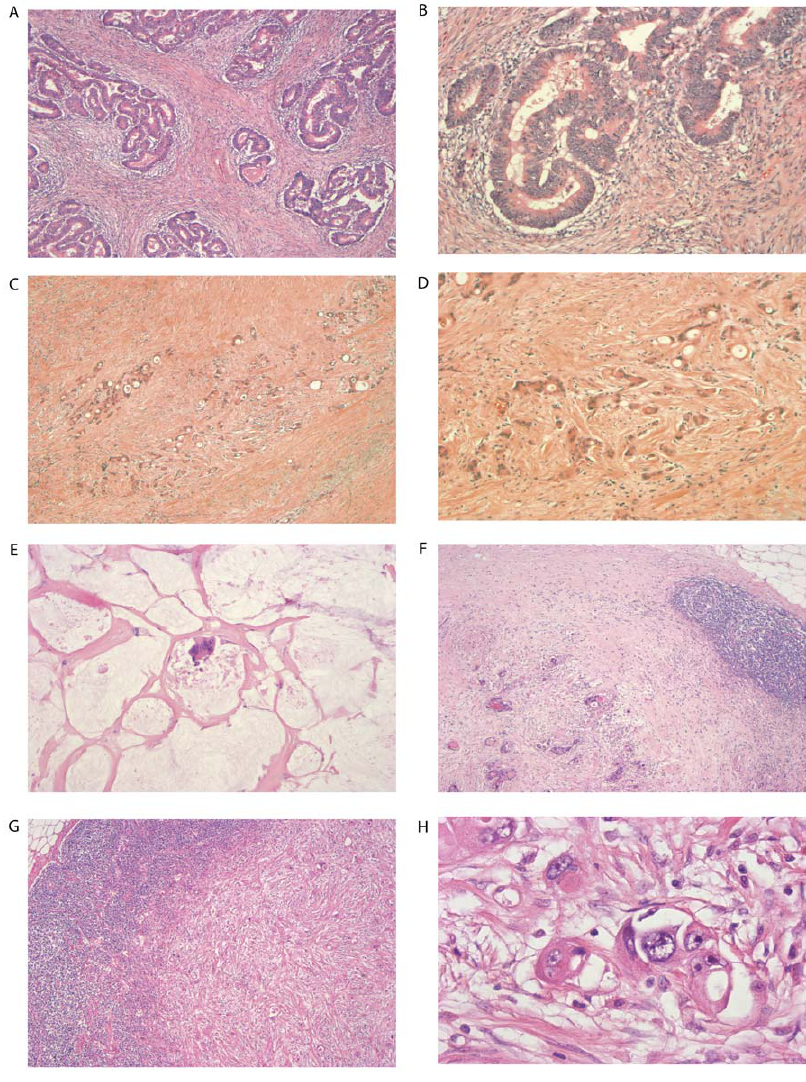
Figure 2. Stages of primary tumor regression and regional lymph node metastasis regression after neoadjuvant radio- chemotherapy. A. HE stained rectal adenocarcinoma with tumor regression grade 1 (40x). B. HE stained rectal cancer tissue with tumor regression grade 1 (100x) C. Rectal carcinoma with tumor regression grade 2 (40x) D. Rectal adenocarcinoma with tumor regression grade 2 (100x). E. Tumor regression grade 3 (100x) in rectal cancer with extracellular mucin accumulation. F. Lymph node metastasis regression grade 2 (40x). G. Lymph node metastasis regression grade 3 (40x). H. Regional lymph node metastasis (400x) in standard HE staining.